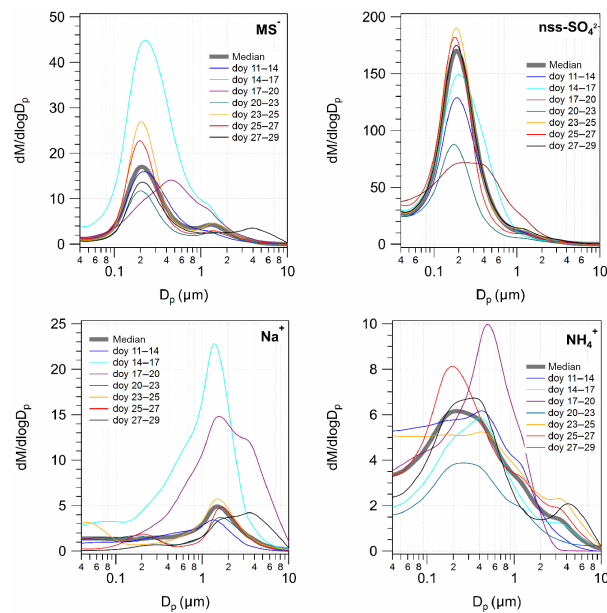
Figure 12. Results from size-segregated (Berner impactor) sam- pling during the campaign 2016 with the following mass portion of the respective ions in the super-micrometer range (>1µm): MS − 14% (a) , nss–SO 2 − 3% (b) , Na + 46% (c) , and NH + 15% (d) . 4 4 The bold gray line is the median mass size distribution of the corre- sponding ion.